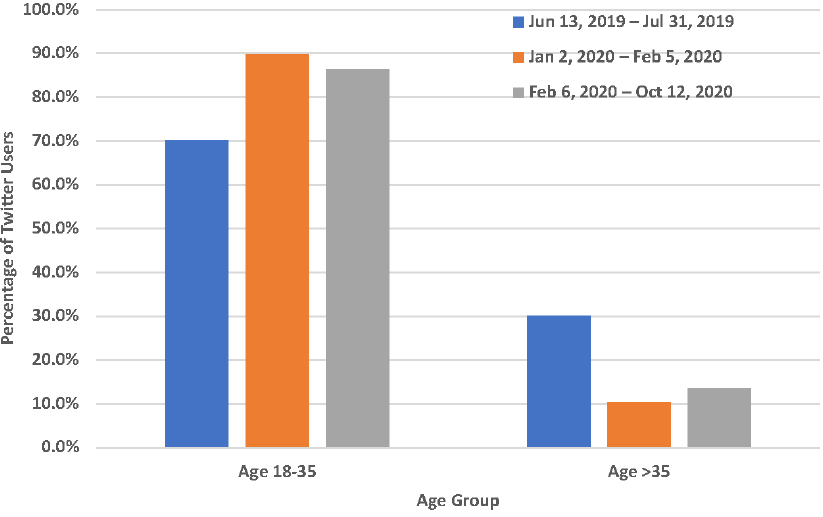
Figure 3. Age characteristics of Twitter users who mentioned quitting vaping. 13 June 2019–31 July